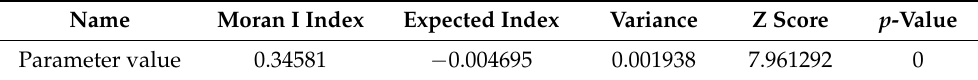
Table 2. Global Moran’s I index of human settlement quality in the Qinghai–Tibet